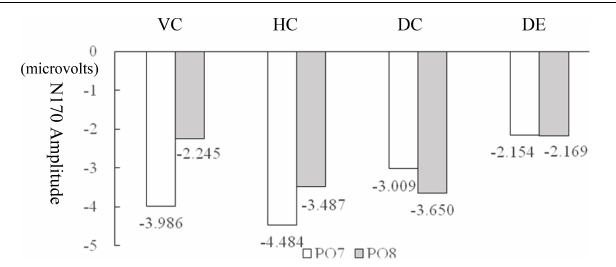
FIGURE 6 | Lateralization effect for adults in the N170 amplitude under the four conditions. VC, viewing Chinese; HC, handwriting Chinese; DC, drawing followed by Chinese recognition; DE, drawing followed by English recognition.